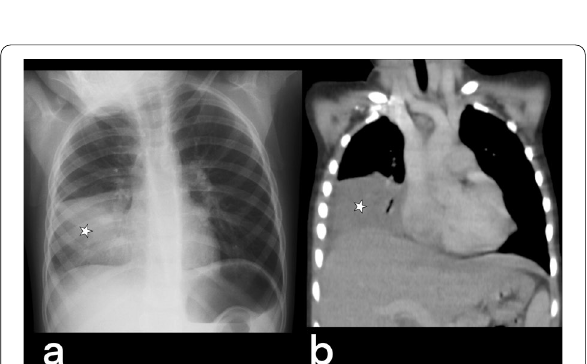
Fig. 17 The chest X-ray ( a ) and coronal reformatted CT ( b ) image without contrast of a 4-year-old girl demonstrate unilateral pleural effusion in the right side (stars). Tuberculous